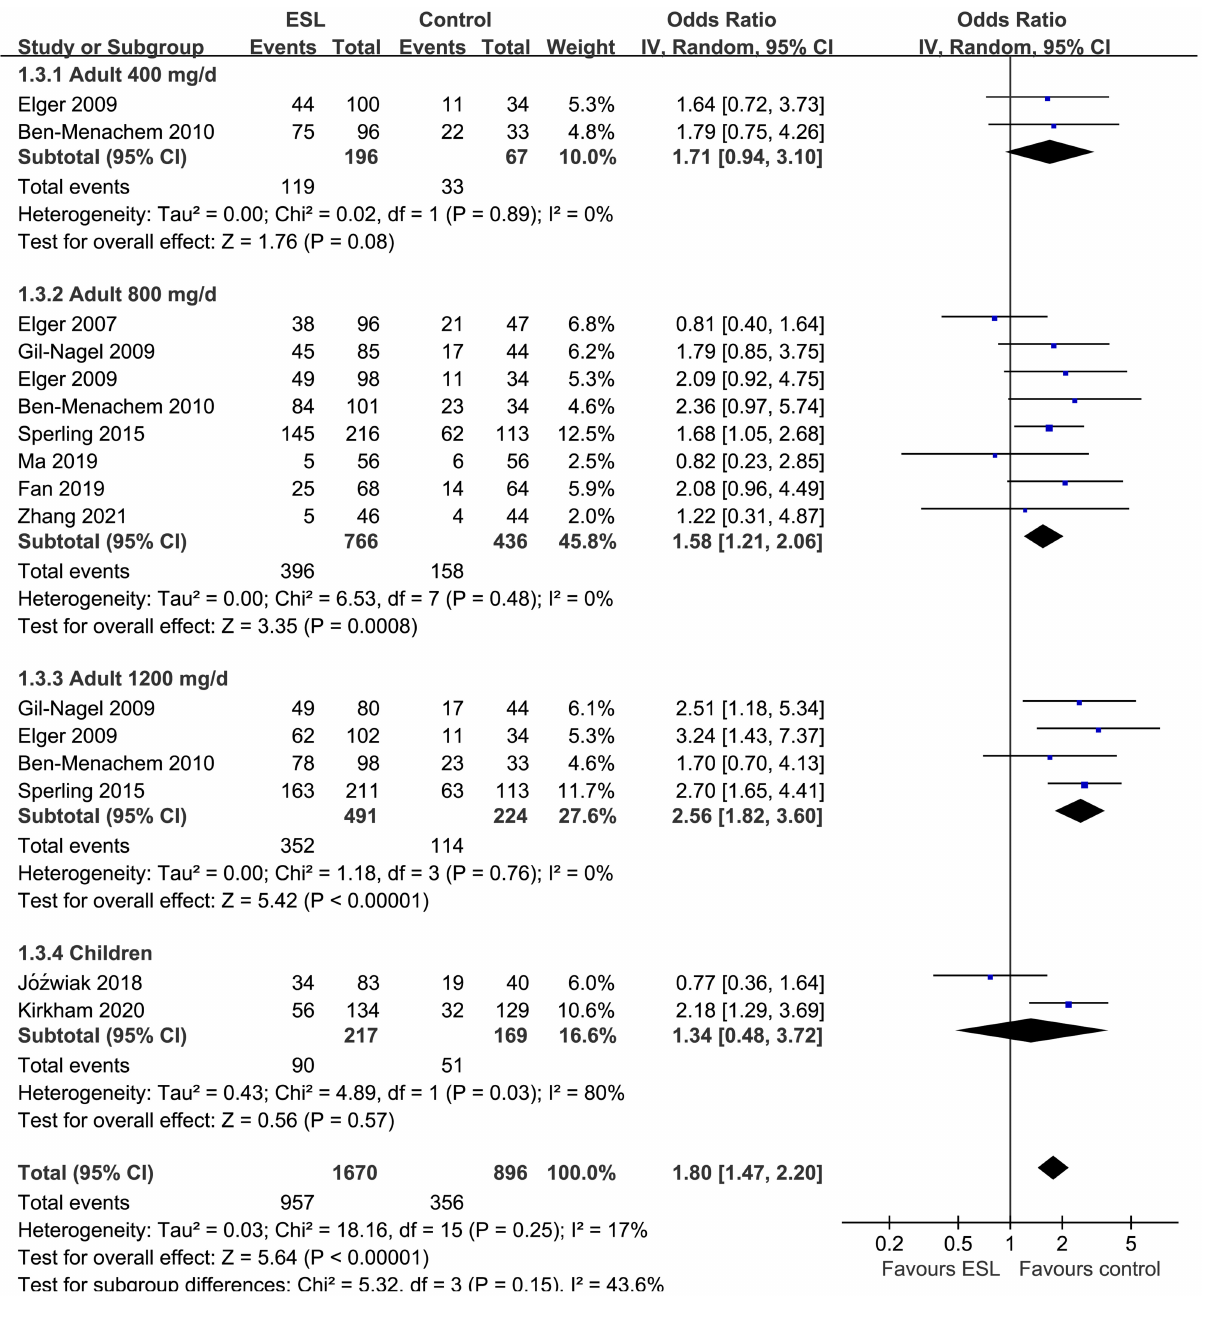
FIGURE 4 | Forest plots for the meta-analysis of the influence of adjunctive ESL on the incidence of overall AE in adults with FOE according to dose of ESL and in children with all